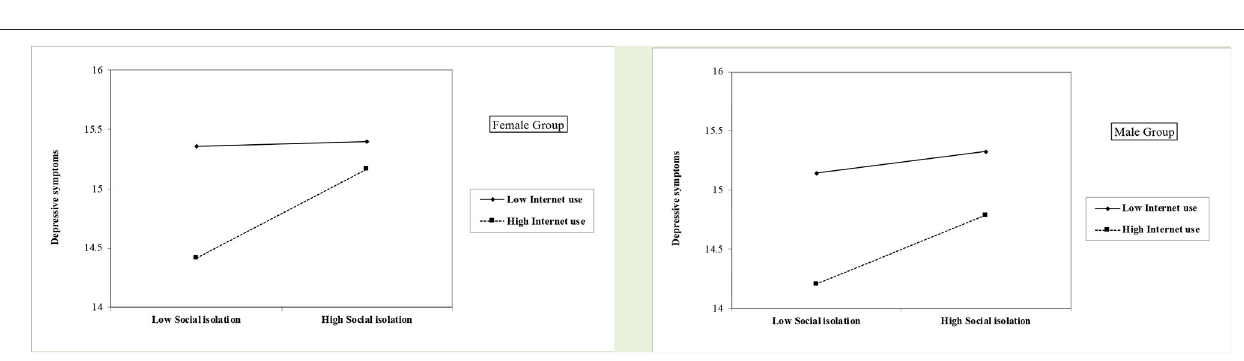
FIGURE 5 | Role of social isolation on depressive symptoms by levels of internet use among the female and male